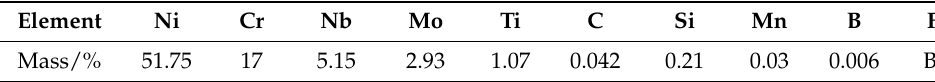
Table 1. Chemical composition of nickel-base superalloy GH4169.